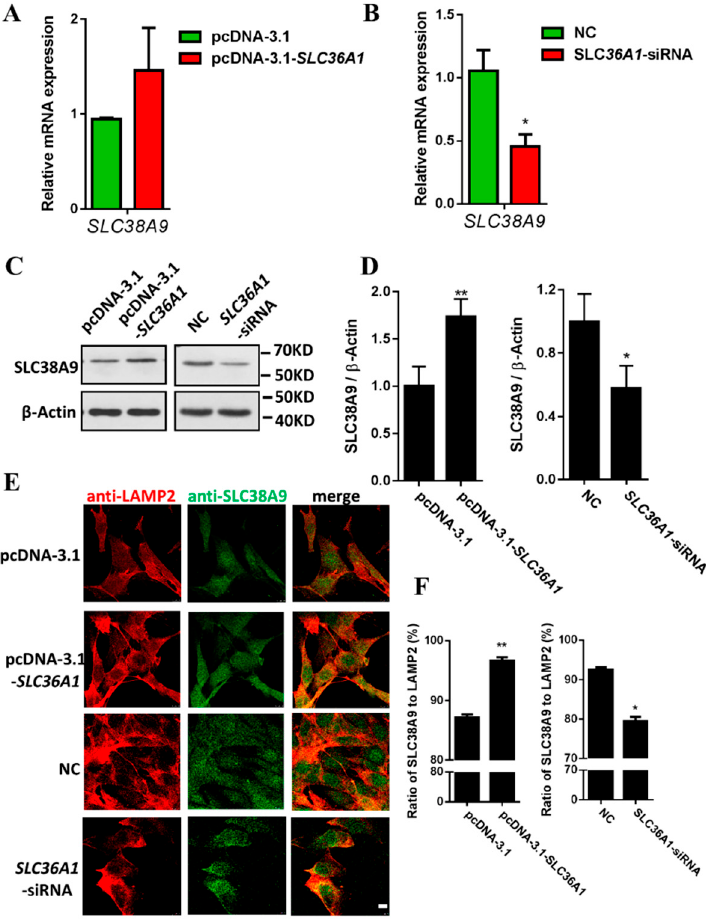
Figure 4. SLC36A1 increases SLC38A9 expression and promotes the translocation of SLC38A9 to LAMP2-positive lysosomal clusters. ( A ) C2C12 cells were transfected with pcDNA3.1-SLC36A1 construct to overexpress SLC36A1. The mRNA level of SLC38A9 was analyzed by qRT-PCR. ( B ) C2C12 cells were transfected with siRNA to knockdown SLC36A1. The mRNA level of SLC38A9 was analyzed by qRT-PCR. ( C ) Immunoblotting analysis of protein samples from ( A , B ) with anti- SLC38A9 or anti- β -Actin antibody. ( D ) Densitometric analysis of the immunodetection of SLC38A9 relative to β -Actin loading control. ( E ) C2C12 cells were transfected with pcDNA3.1-SLC36A1 construct or siRNA to overexpress or knockdown SLC36A1 and stained with anti-SLC38A9 or anti- LAMP2. Scale bar: 10 µ M. ( F ) Ratio of SLC38A9 to LAMP2 (%). To assess SLC38A9 translocation, the numbers of SLC38A9 and LAMP2-positive spots per cell were calculated using IPP6.0 and Image J software. Values are the mean ± SEM; n = 3; * p < 0.05; ** p <